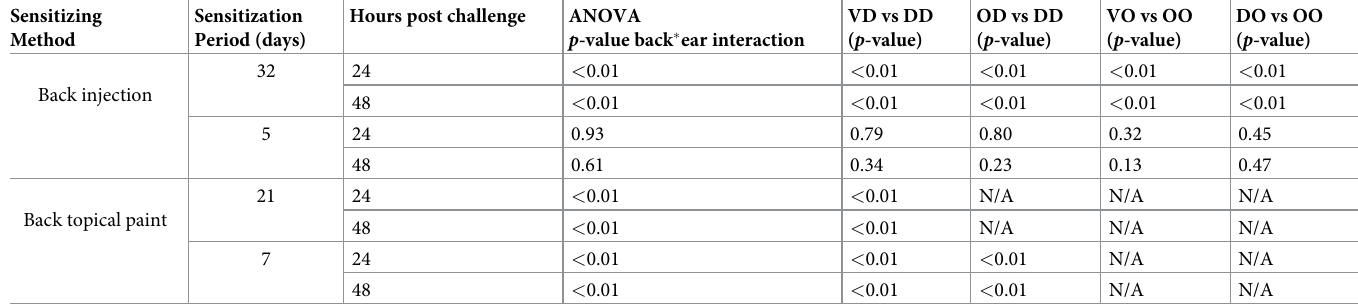
Table 1. P-values of contrasts examining the effect of a sensitizing hapten. Reported are ANOVA p -values for the overall interaction of sensitization � ear treatment, fol- lowed by p -values of the hapten-specific contrasts at either 24 or 48 hours post challenge. Comparisons investigated the effect of sensitizing the pig with a hapten prior to hapten challenge. Primary comparisons included vehicle sensitized, DNFB challenged (VD) compared to DNFB sensitized, DNFB challenged (DD) and vehicle sensitized, OXA challenged (VO) compared to OXA sensitized, OXA challenged (OO). Also included is the contrast of OXA sensitized, DNFB challenged (OD) compared to DNFB sensitized, DNFB challenged (DD) and contrast of DNFB sensitized, OXA challenged (DO) compared to OXA sensitized, OXA challenged (OO) which explores the hap- ten-specific response of the